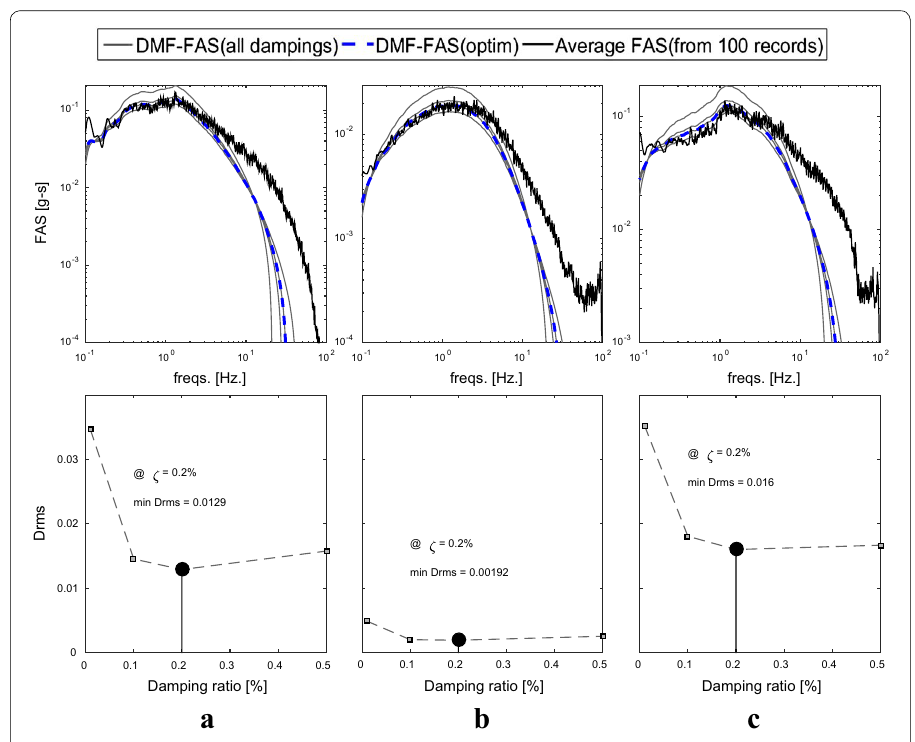
Fig. 4 Estimation of the optimal damping ratio for the DMF approach. Top figures show the resulting FAS using DMF with different damping values and bottom figures show their corresponding D rms when compared against the average FAS from the set of 100 spectrum compatible series time‑series. Left to right: results corresponding to the NRC, NGA and NUC target